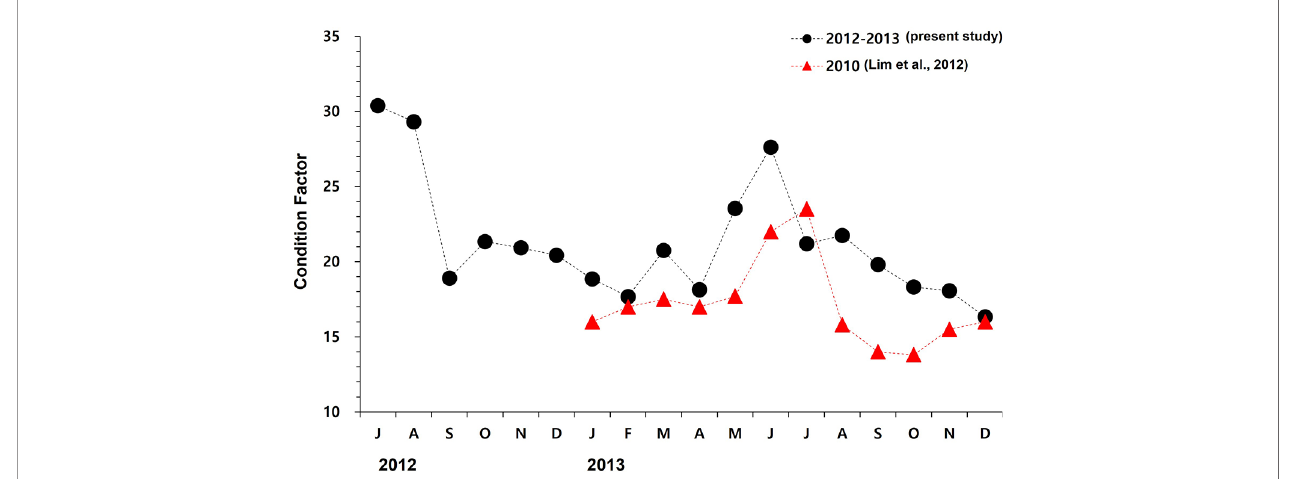
FIGURE 8 | The monthly mean condition factor (i.e., ((wet tissue weight/total weight) x 100) of oysters cultured in this study (July 2012 to December 2013) and the data reported by Lim et al. (2012) measured from the study site Euhangri